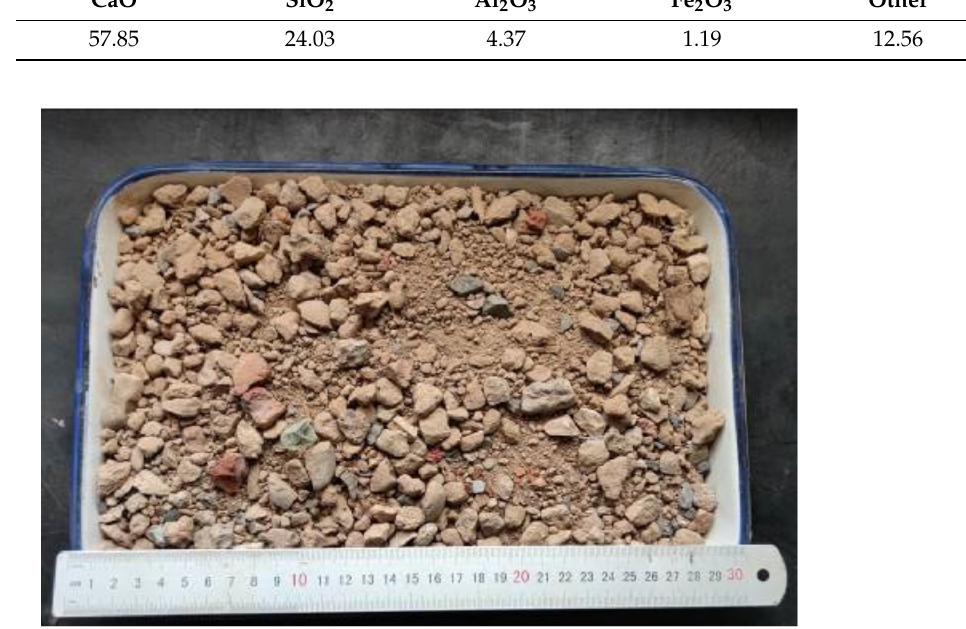
Figure 1. Recycled aggregates from C&D